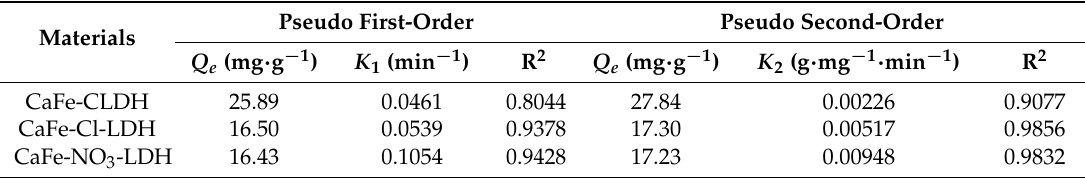
Figure 4. Kinetic fitting curve of arsenic adsorption on the three materials: ( a ) CaFe-CLDH; ( b ) CaFe-Cl-LDH; ( c ) CaFe-NO 3 -LDH (Experimental condition: initial concentration of arsenate was 10 mg·L − 1 , materials dosage = 0.2 g·L − 1 , initial pH = 6.0). Table 4. Fitting curve parameters of arsenic adsorption kinetic equation.